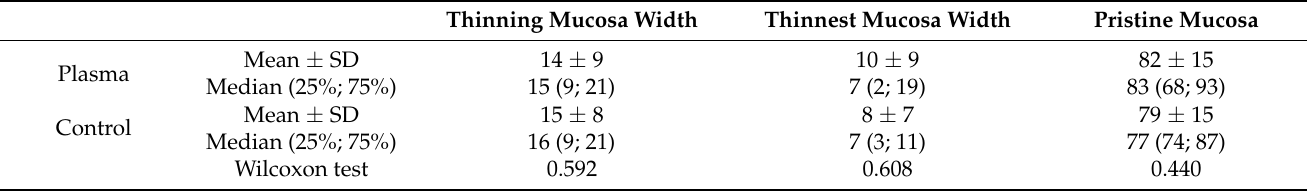
Table 3. Histometric measurements in micromillimeters of the mean values of the thinning, lowest and pristine mucosa